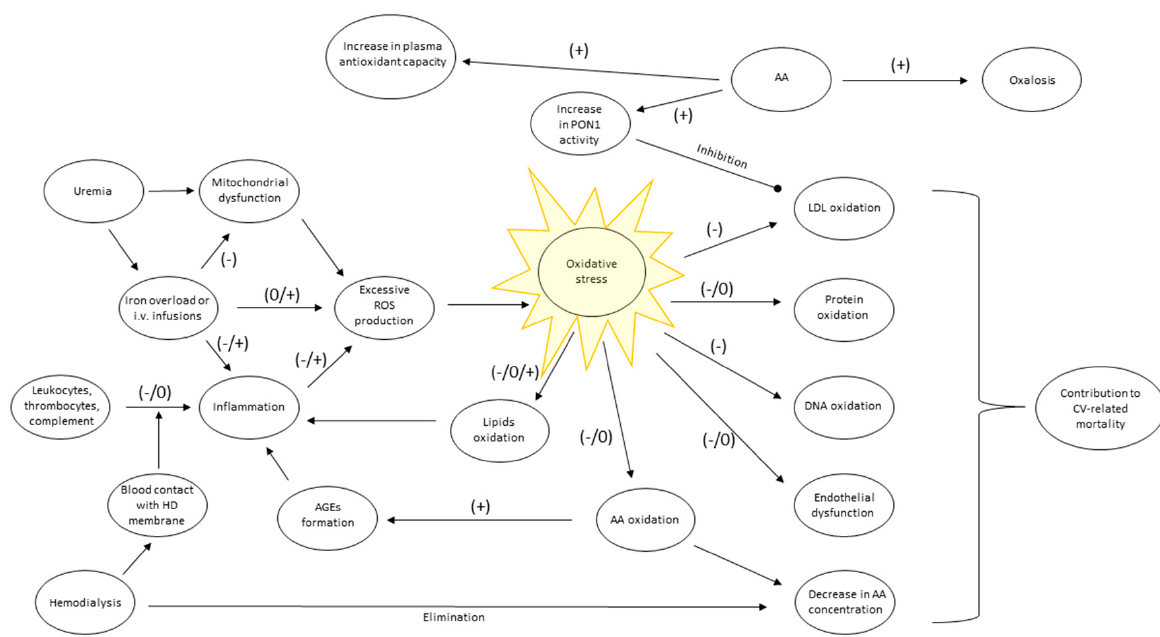
Figure 1. Primary sources and consequences of oxidative stress in hemodialysis patients, and influence of AA administration on oxidative stress-related processes reported in studies on hemodialysis patients, presented later: (-) inhibition, (0) no effect, (+) augmentation of a process by AA administration. AA, ascorbic acid; AGEs, advanced glycation end-products; CV, cardiovascular; HD, hemodialysis; LDL, low-density lipoprotein; PON, paraoxonase; ROS, reactive oxygen species.